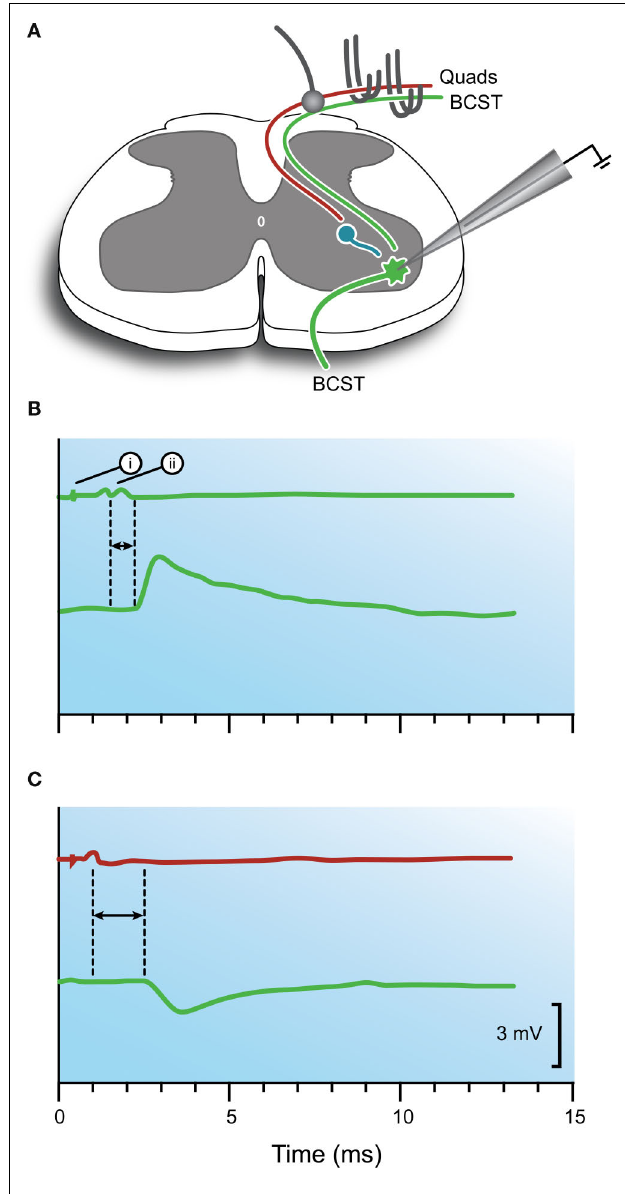
FIGURE 2 | Intracellular responses recorded in motoneurons after stimulation of monosynaptic excitatory and reciprocal inhibitory pathways. (A) Schematic showing the experimental confi guration. A motoneuron innervating BCST is impaled with an intracellular recording electrode. Stimulating electrodes can activate either agonist (BCST) or antagonist (Quads) 1a afferents within muscle nerves. Arrival of the afferent volley at the dorsal root entry zone is monitored with a ball electrode. (B) Upper trace shows recording from ball electrode and indicates when